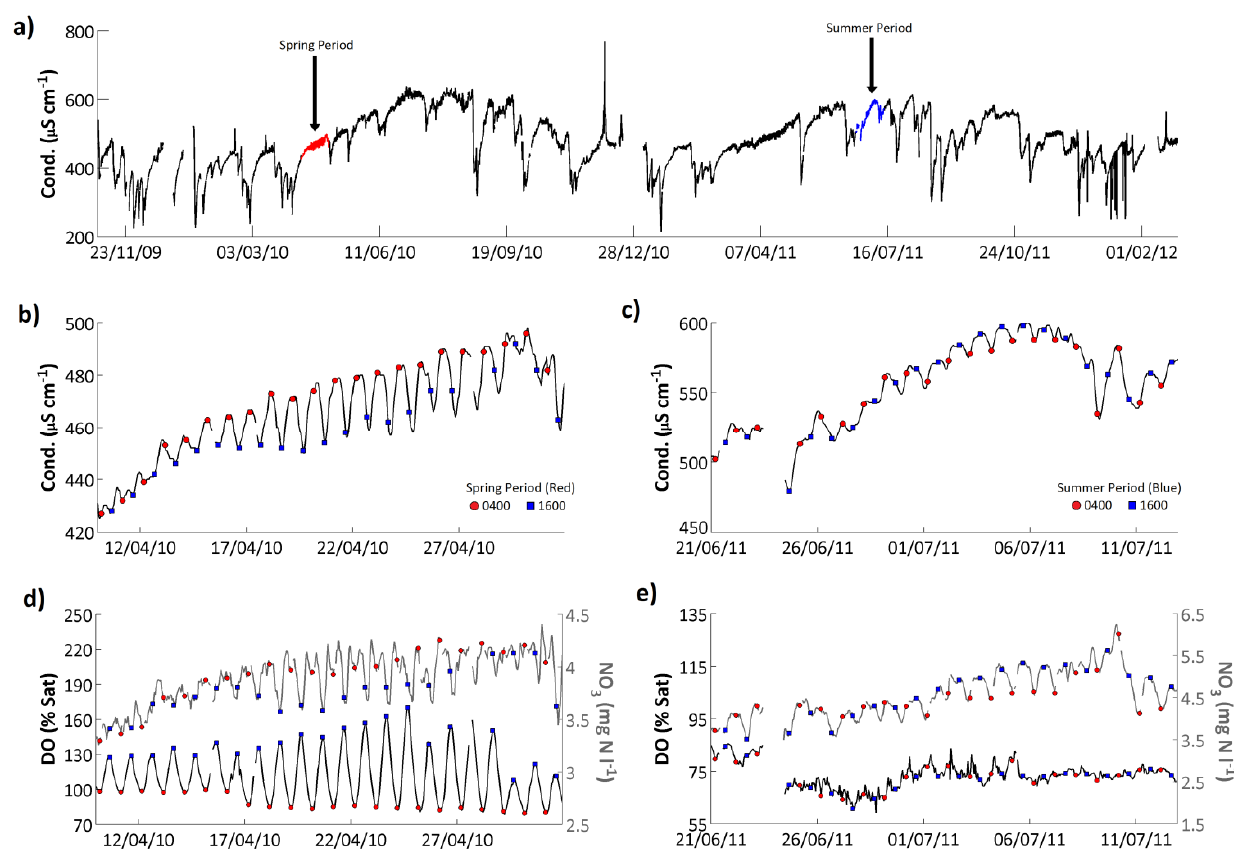
Figure 9. ( a ) Hourly conductivity record from the River Enborne at Brimpton. Representative ( b ) spring and ( c ) summer periods are highlighted and shown in expanded form, respectively; ( d ) shows dissolved oxygen and ( e ) nitrate concentrations for the same periods; In ( b – d ), the 0400 and 1600 GMT data points are highlighted for